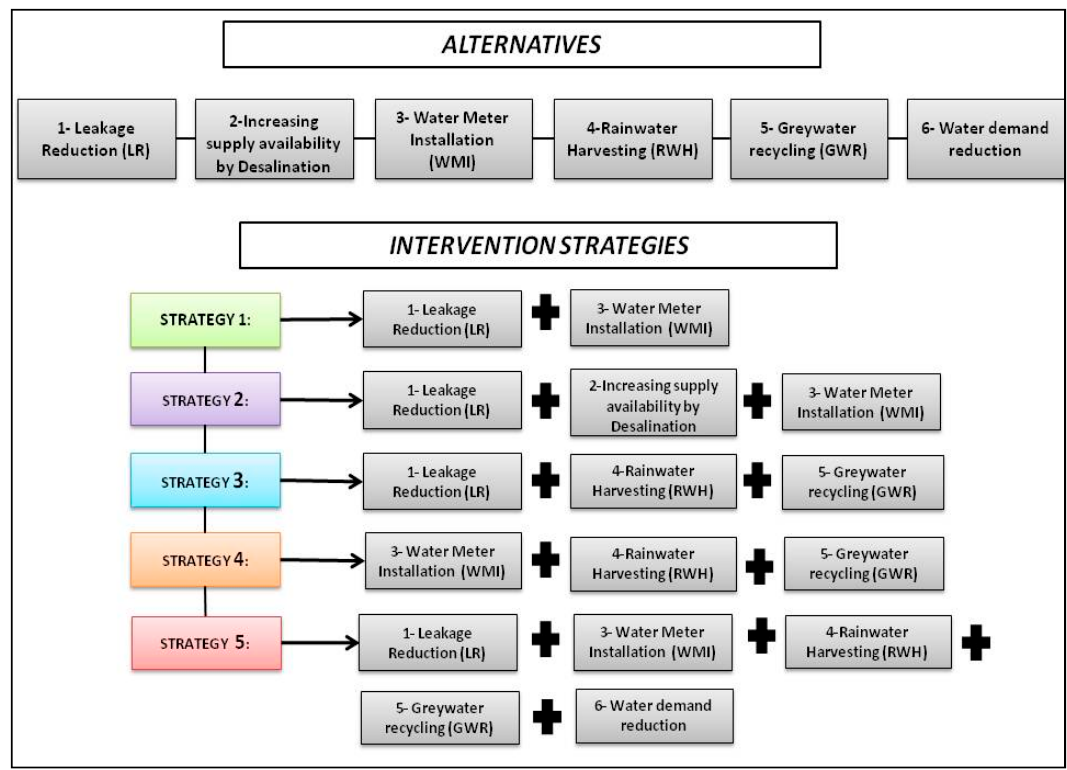
Figure 5. Intervention strategies applied to the UWS model.